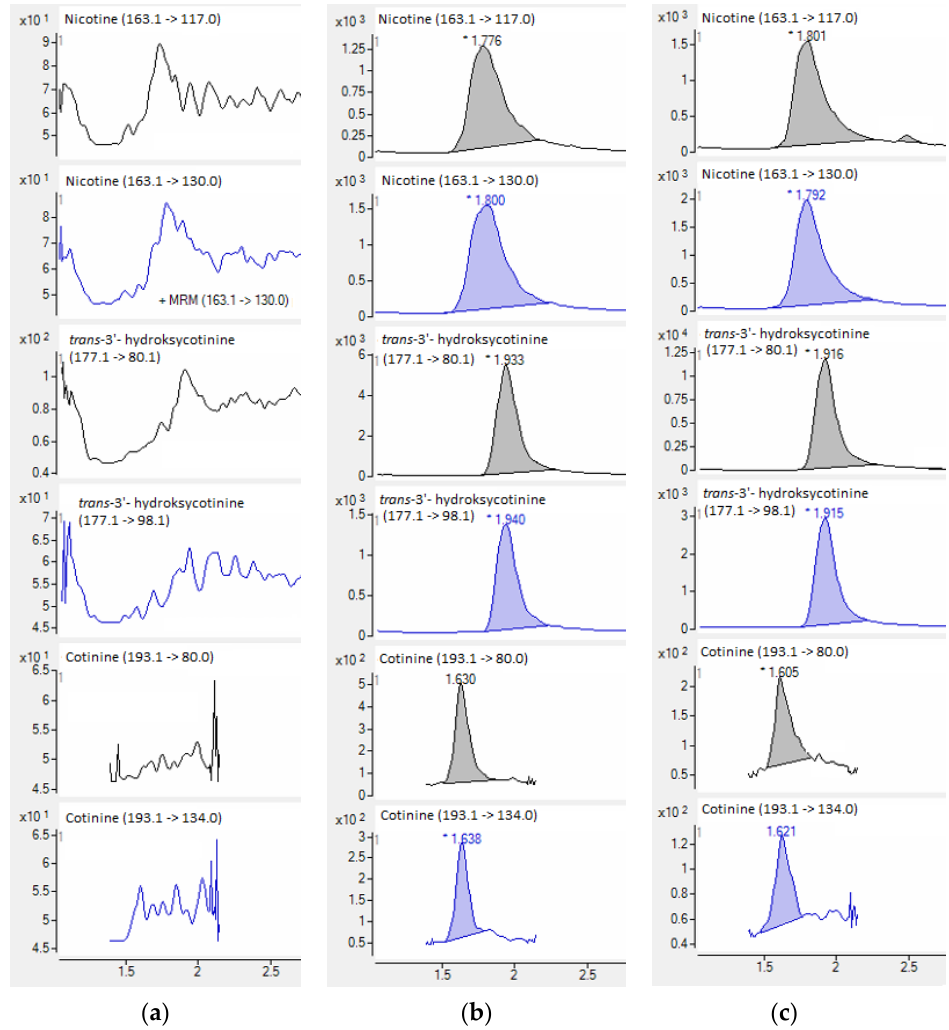
Figure 6. HPLC-QQQ-MS/MS chromatograms of quantitative (black) and confirmatory (blue) transitions of nicotine and metabolites from the blank plasma sample ( a ), plasma samples used in the validation process ( b ), and smoker’ plasma sample ( c ).